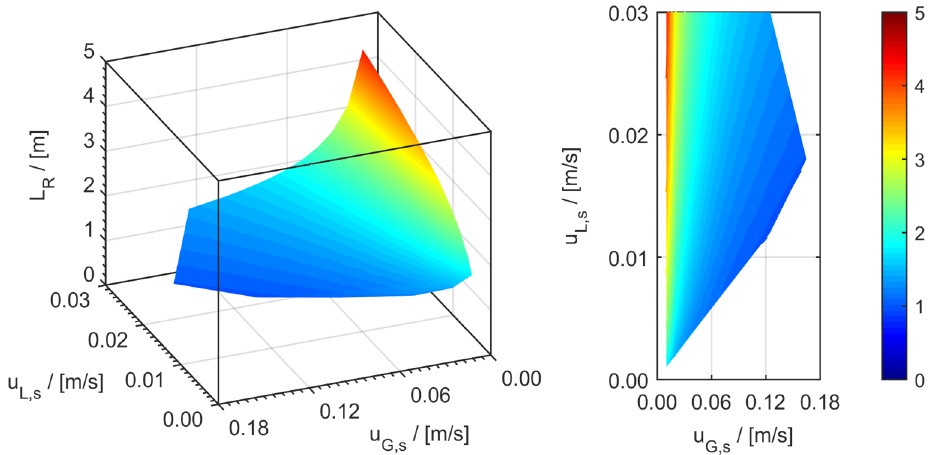
Figure 23. Required reactor length of trickle-bed reactors operating at different gas and liquid superficial velocities.